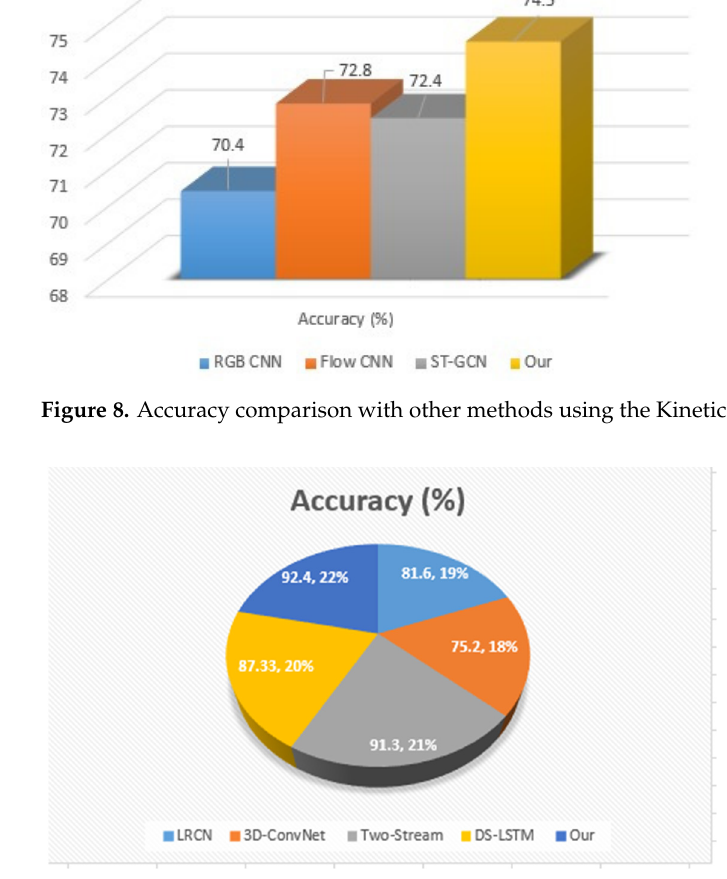
Figure 9. Accuracy comparison with other methods using the UCF-Motion dataset. Table 4. Accuracy (%) achieved with previous models for cross-subject (CS) evaluation using SYSU dataset.